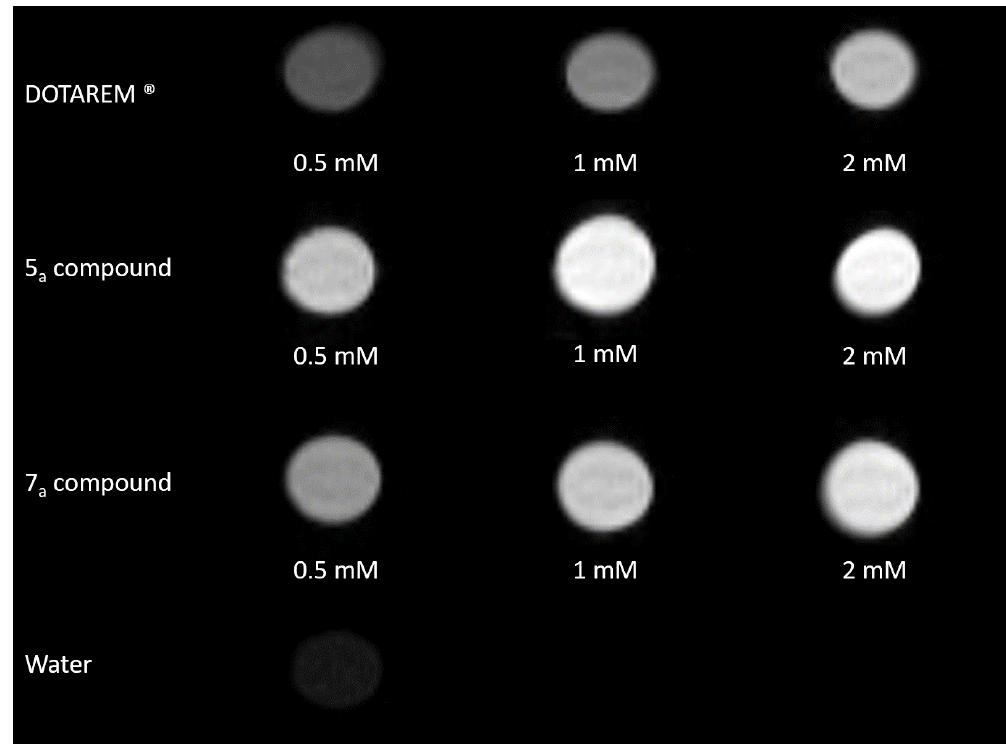
Figure 4. Phantom images recorded at 1T and 25 °C of DOTAREM ® and synthesized gadolinium complexes 5 a and 7 a .